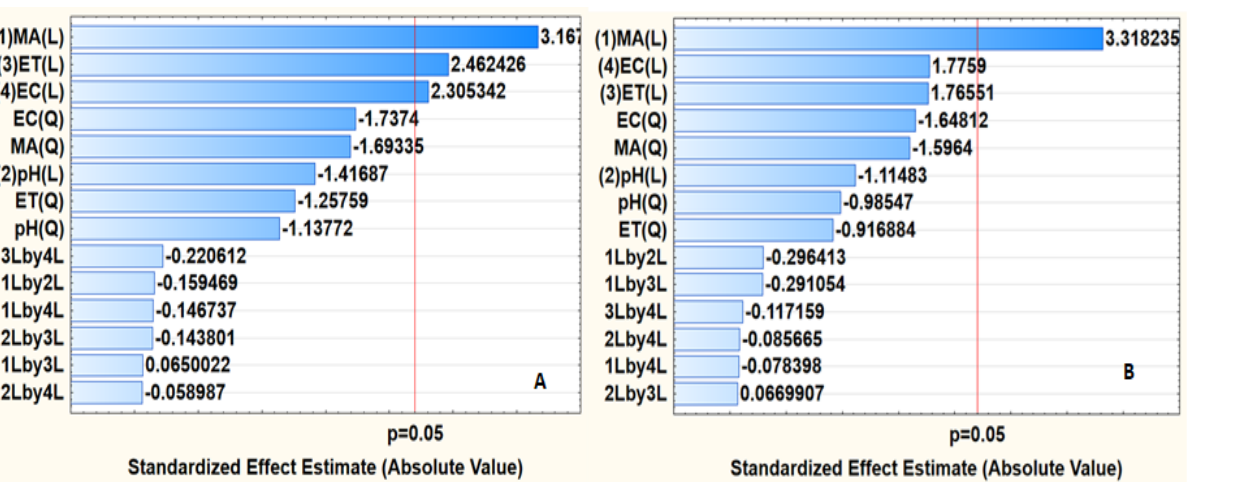
Pareto chart of standardised effects: ( A ) Au(III) and ( B ) Pd(II). MA = mass of adsorbent, ET = extraction time, EC = eluent concentration, 1Lby2L = interaction between MA and pH, 1Lby3L = interaction between MA and ET, 1Lby4L = interaction between MA and EC, 2Lby3L = interaction between pH and ET, 2Lby4L = interaction between pH and EC, 3Lby4L = interaction between ET and EC, Q represents quadratic interactions.